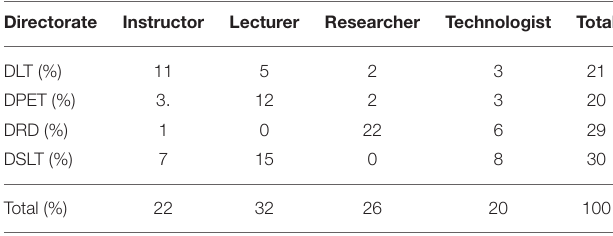
TABLE 1 | Percentage distribution of respondents by designations and